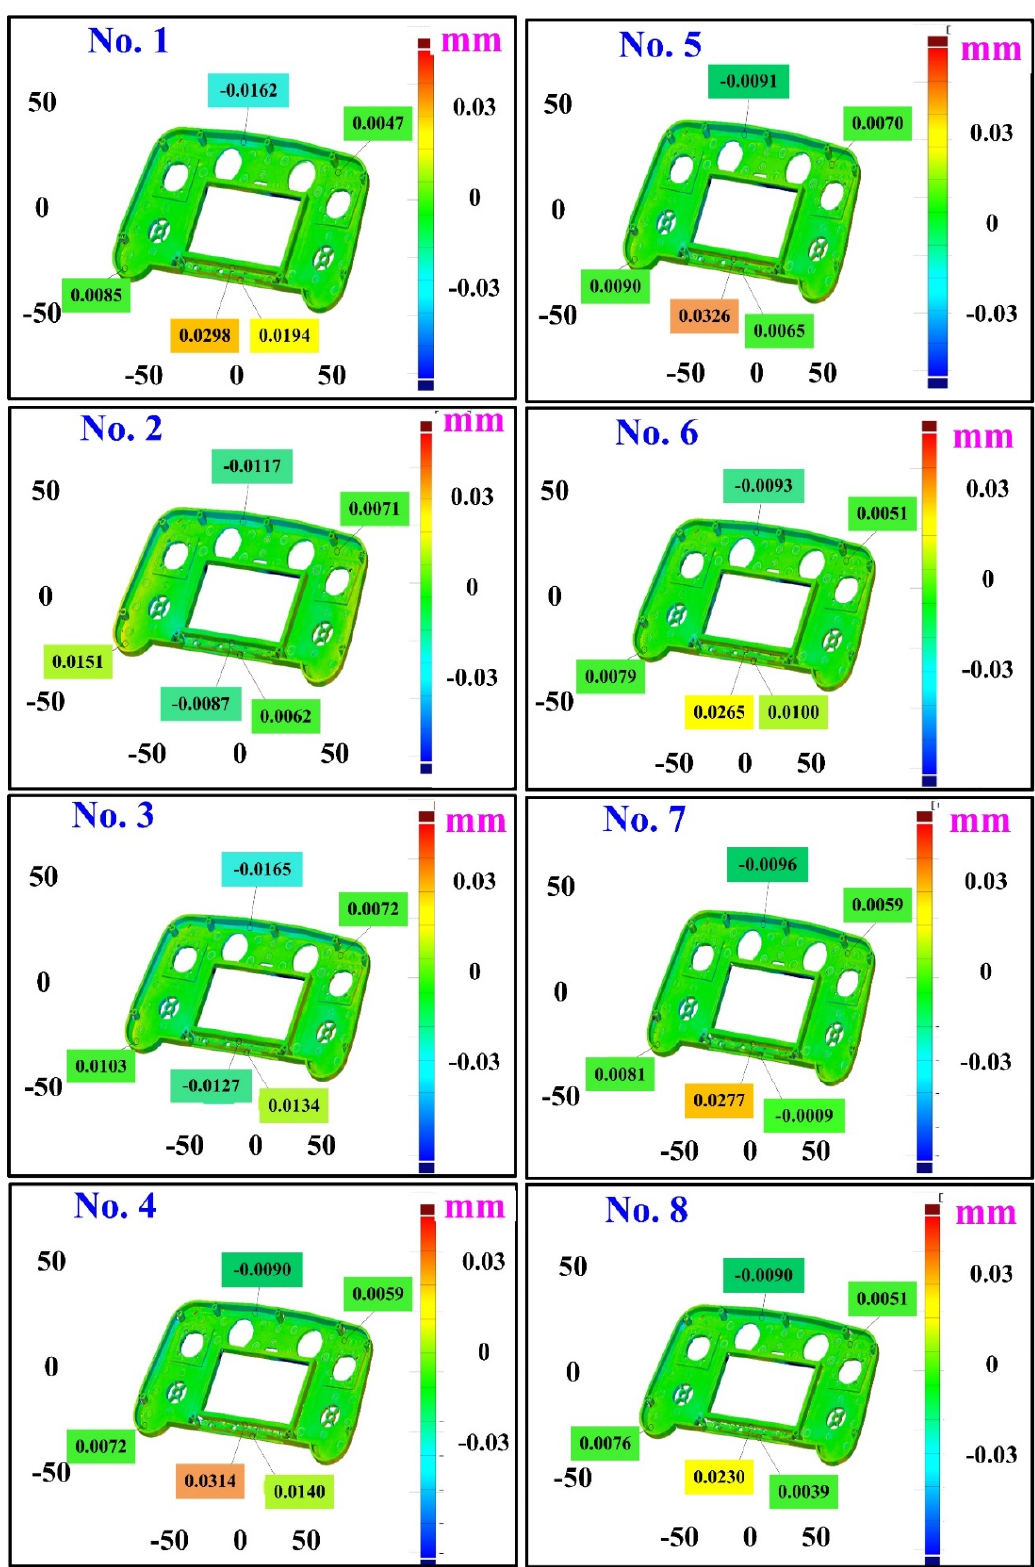
Figure 7. CAV results of light-colored plastic part. Data for five measurements in figure are only representative analysis results.